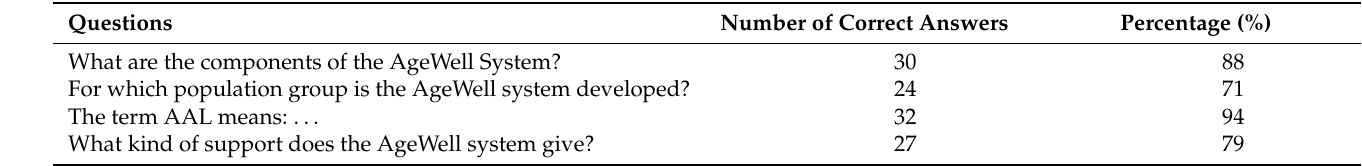
Table 8. Comprehension tasks/questions ( n = 34).